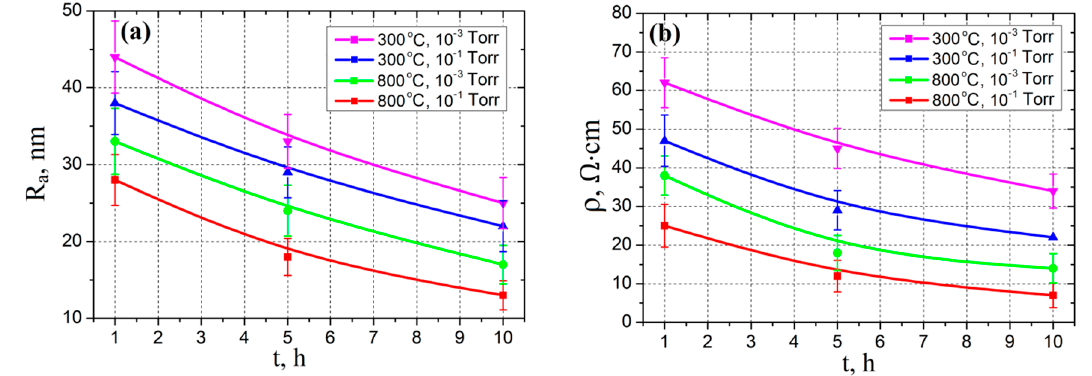
Figure 5. Experimental investigation of annealing time effect on surface roughness ( a ) and resistivity ( b ) at different substrate temperatures and chamber pressures.